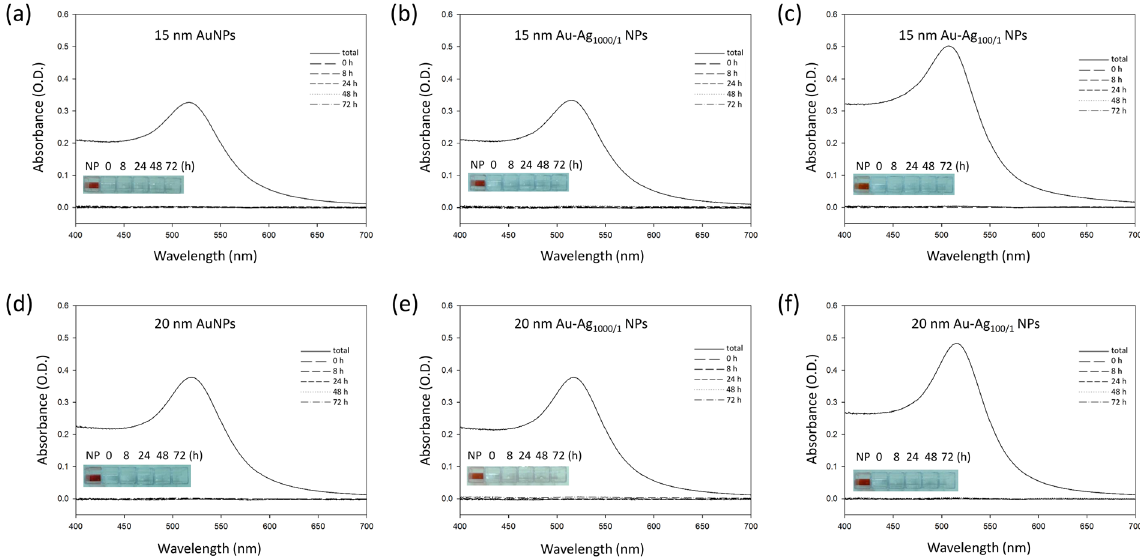
Figure 4. UV-Vis absorption spectra of the NP detachment tests. The solutions were collected at 0 h, 8 h, 24 h, 48 h, and 72 h. The absorption spectra were measured to determine the amount of NPs in solution. The inset images are of the original NP stock solutions used to make the NP-paper composites (“NP”) and the water solutions collected after the paper samples had been immersed for 0 h, 8 h, 24 h, 48 h, and 72 h. The results show that no significant NP signal can be seen in solution during this time